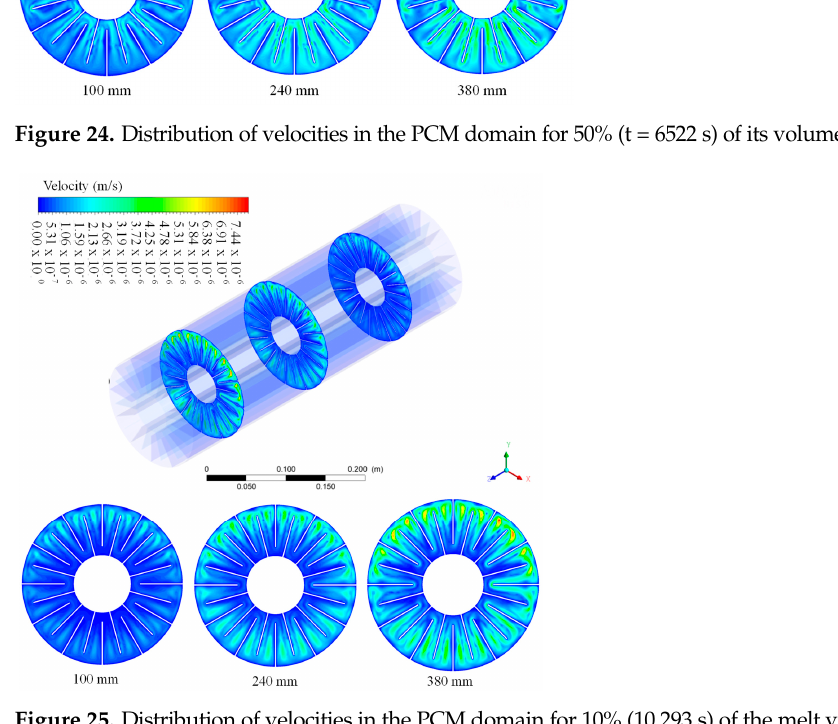
Figure 25. Distribution of velocities in the PCM domain for 10% (10293 s) of the melt volume.